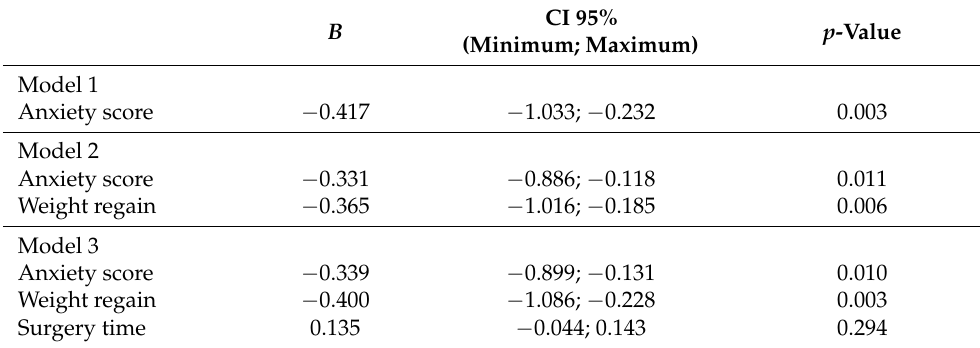
Table 4. Linear regression between the anxiety symptoms score and the general physical component of the quality of life of women more than 24 months after undergoing bariatric